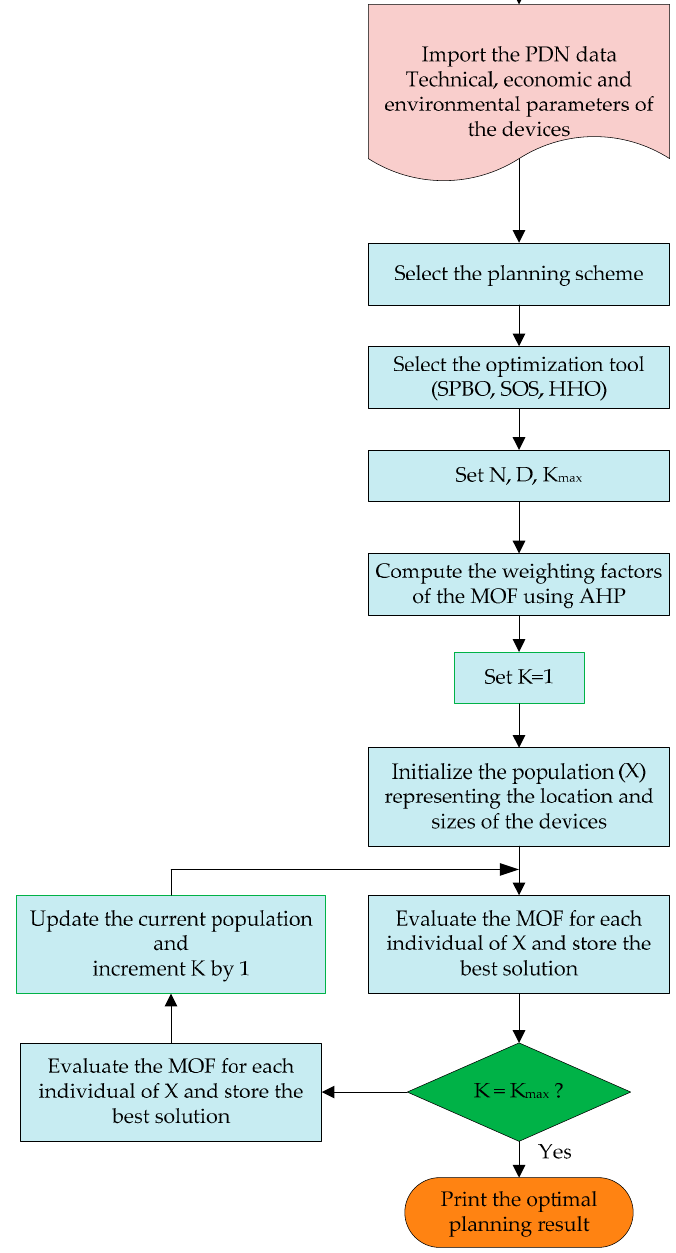
Figure 2. Implementation of optimization tools for the optimal planning of DN.